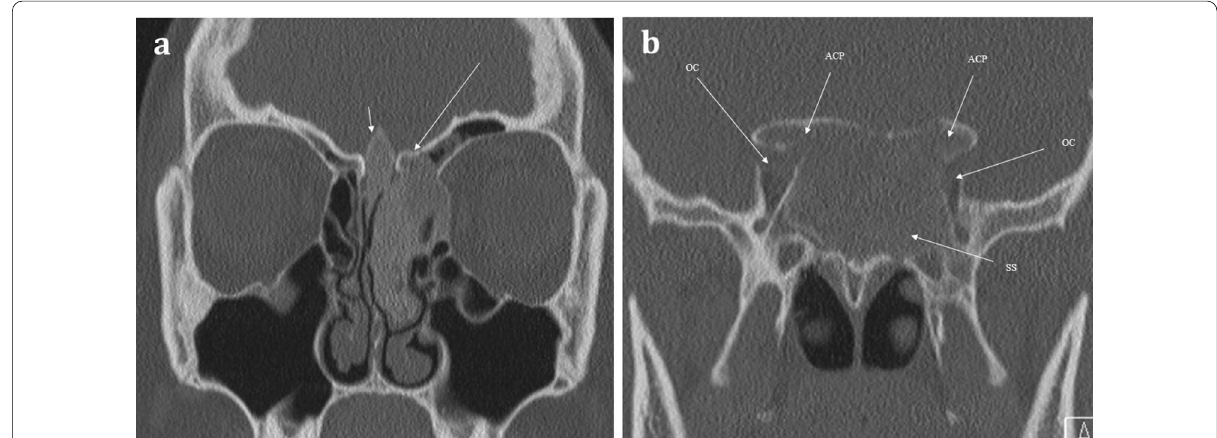
Fig. 17 Fibrous Dysplasia. 24-year-old female patient with history of diabetes and café au lait spots presenting with long standing anosmia and nasal congestion, and acute left sided visual loss. Coronal CT images showing expansile multifocal osseous lesions with typical internal ground-glass matrix, involving the left cribriform plate (long arrow, a ) and crista galli (short arrow, a ). This is causing remodelling of the olfactory fossae and is affecting the olfactory pathway. There are similar expansile lesions affecting the anterior clinoid processes (ACP) and the sphenoid sinus (SS) which causes compromise of both optic nerve canals (OC), worse on the left—this accounts for the visual loss in the left eye. The patient was diagnosed with McCune–Albright syndrome (polyostotic fibrous dysplasia with cutaneous and endocrine abnormalities), and surgical decompression of the left optic canal was